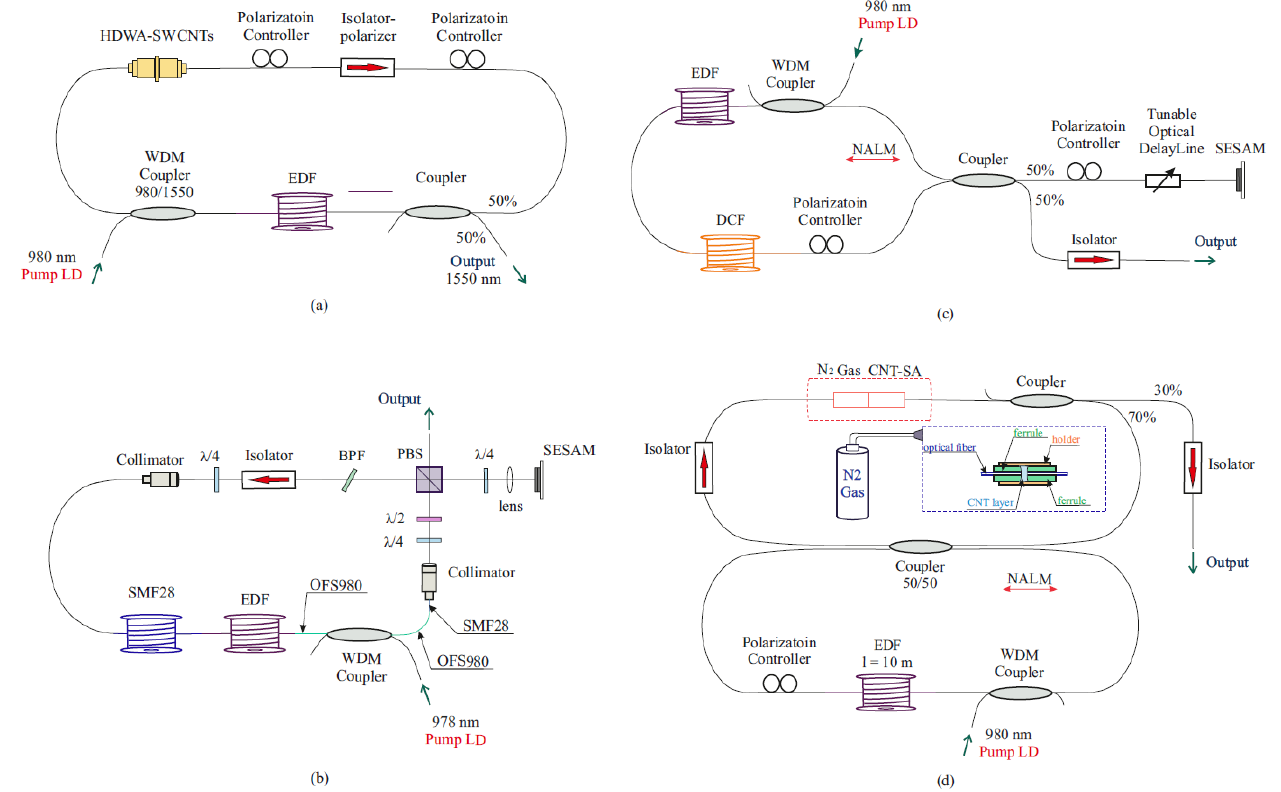
Figure 25. Schemes of fiber lasers with hybrid mode locking: ( a ) using carbon nanotubes and nonlinear polarization rotation; ( b ) using a semiconductor saturable absorber and nonlinear polarization rotation; ( c ) using a semiconductor saturable absorber and a nonlinear amplifying loop mirror; and ( d ) using carbon nanotubes and a nonlinear amplifying loop mirror.